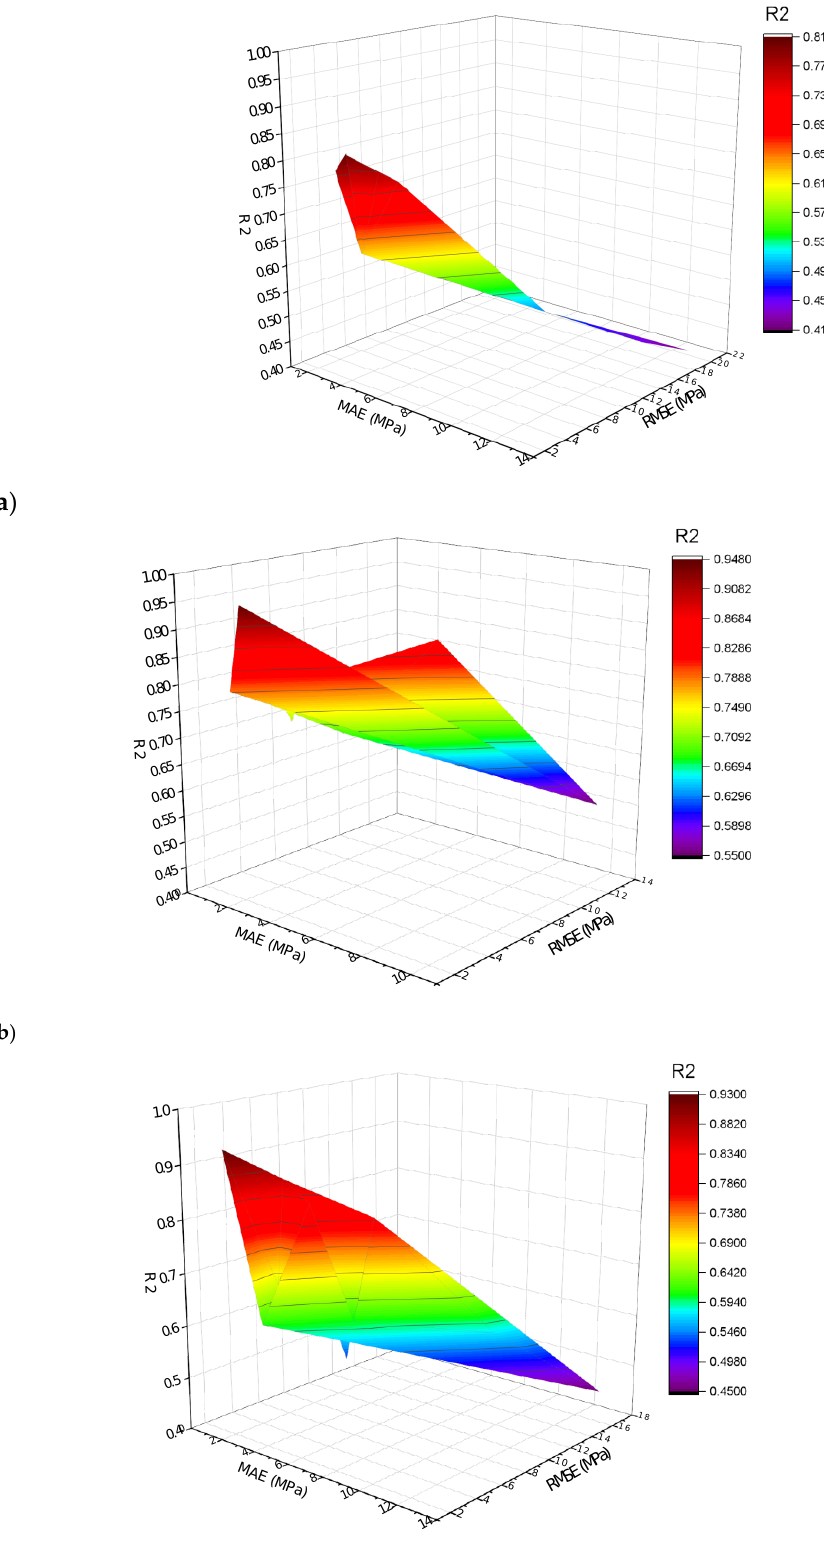
Figure 16. Compressive strength statistical representation: ( a ) MLPNN; ( b ) MLPNN-AdaBoost; ( c ) MLPNN-Bagging.